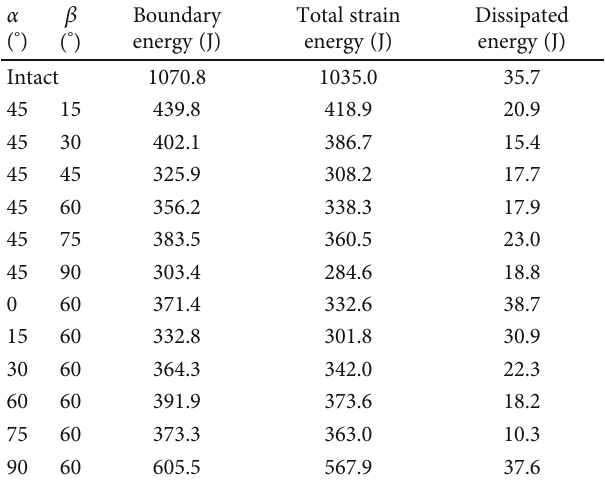
Table 5: Energy indexes in the peak stress of numerical